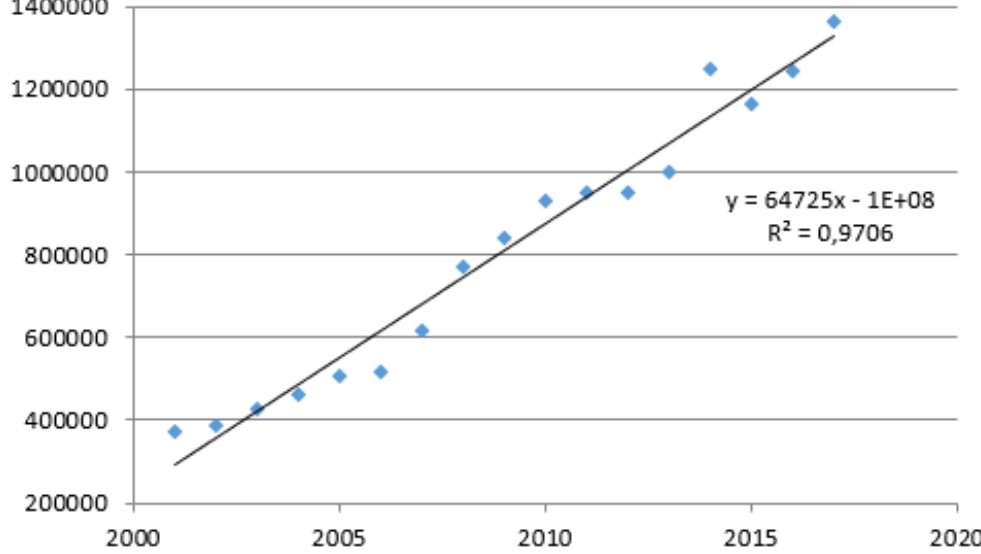
Figure 1. Exports volume of pharmaceutical products from Israel to the EU, 2001-2017 (USD Thousand)